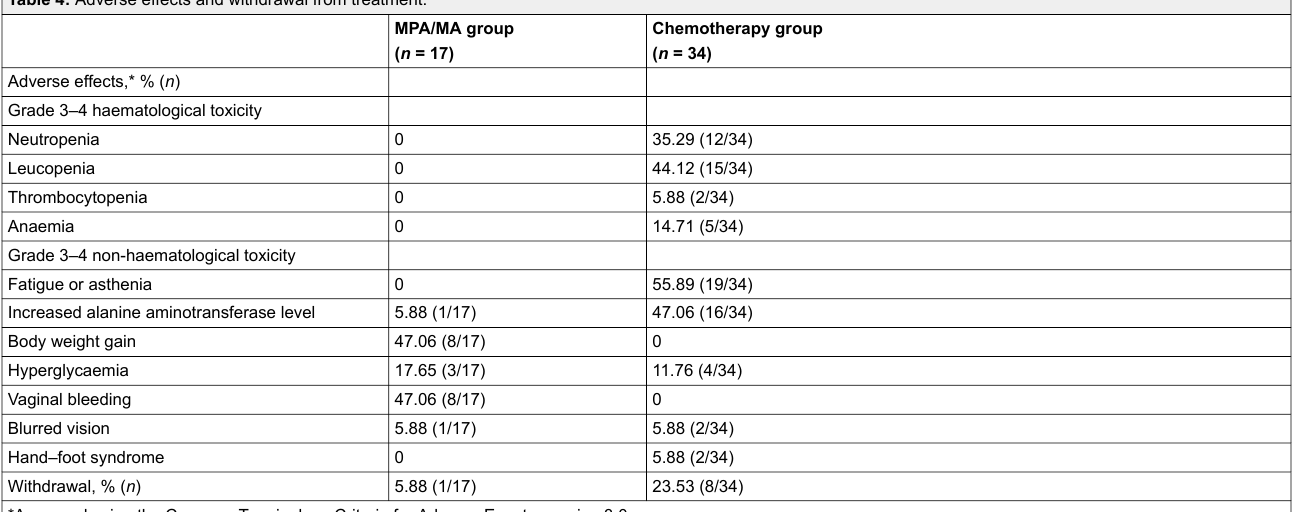
Table 4: Adverse effects and withdrawal from